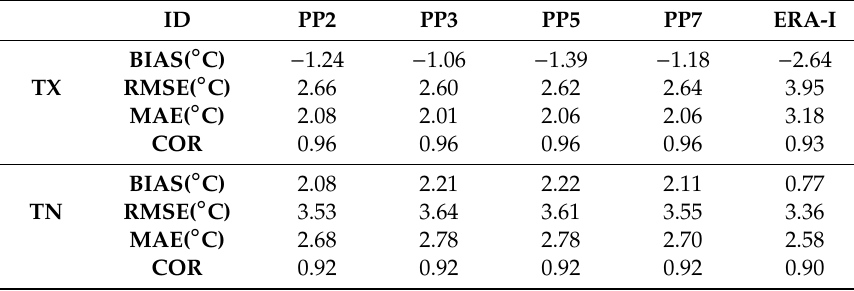
Table 6. Statistical metrics of the four simulations in the total grid points for daily minimum temperature (TN), daily maximum temperature (TX) for 2000–2004, over the area of Greece.